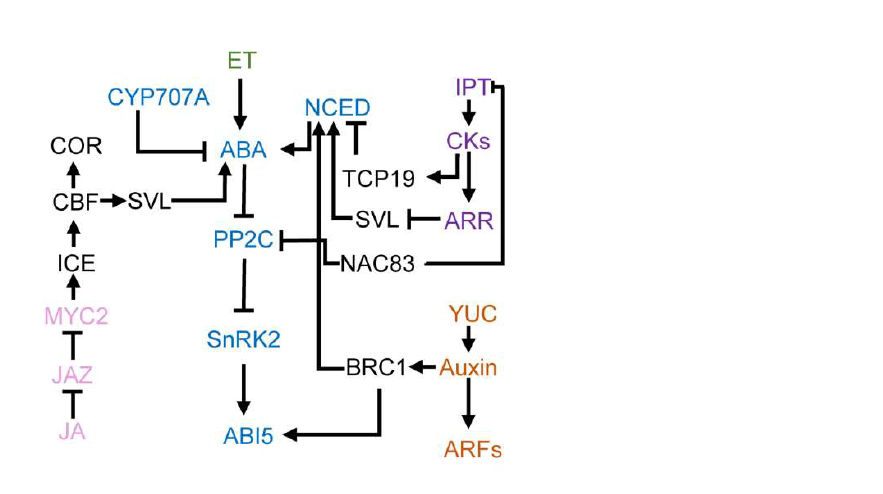
Figure 3. The crosstalks between ABA and other phytohormones in regulating bud dormancy release. Auxin and ABA crosstalk through BRC1-mediated hormone networks in axillary bud dormancy. BRC1 not only activates ABA signaling factors ABI5 but also up-regulated the expression of the key enzyme gene NCED3 by combining with other proteins. CKs and ABA plays antagonistic role during bud dormancy release. Several transcriptional factors are involved in this process, such as TCP19, SVL and NAC83. In autumn, cold exposure activates JA biosynthesis, both JAZ and MYC2 interact with ICE, forming the ICE-CBF-COR cascade. As the CBF-DAM cascade regulates bud dormancy in popular, it is possible that the crosstalk between JA and ABA can be mediated by MYC2-ICE-CBF-DAM cascade, and induce/maintain bud dormancy. Ethylene has been shown to increase endogenous ABA and maintain bud dormancy in several species, but the mechanism is still need to be investigated. ABA metabolism and signaling is marked in blue; cytokinin metabolism and signaling is marked in purple; auxin metabolism and signaling is marked in orange; ethylene is marked in green; Jasmonic acid metabolism and signaling is marked in pink. Note that this overview summarizes interactions reported in different species or environmental condition, which are not necessarily occurring simultaneously. Full lines and dashed lines specify established.